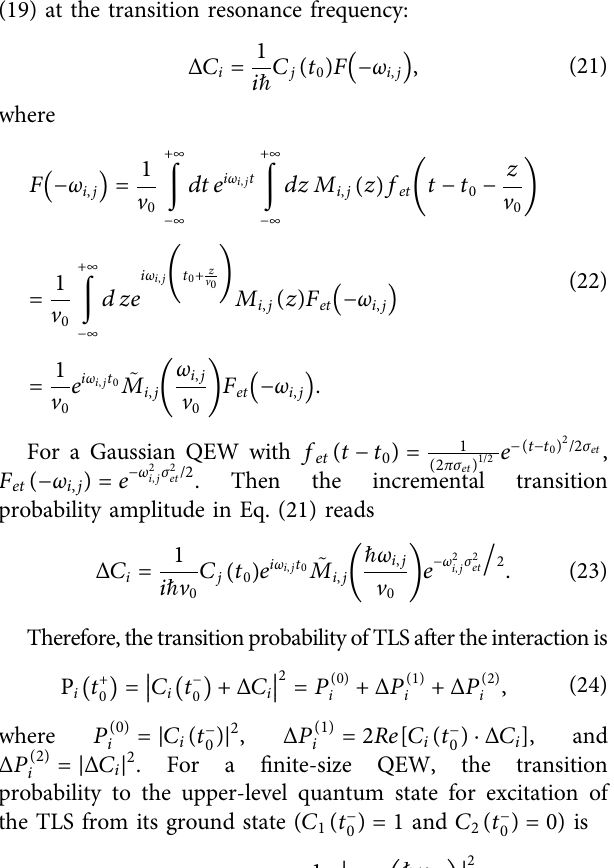
Frontiers in Physics |